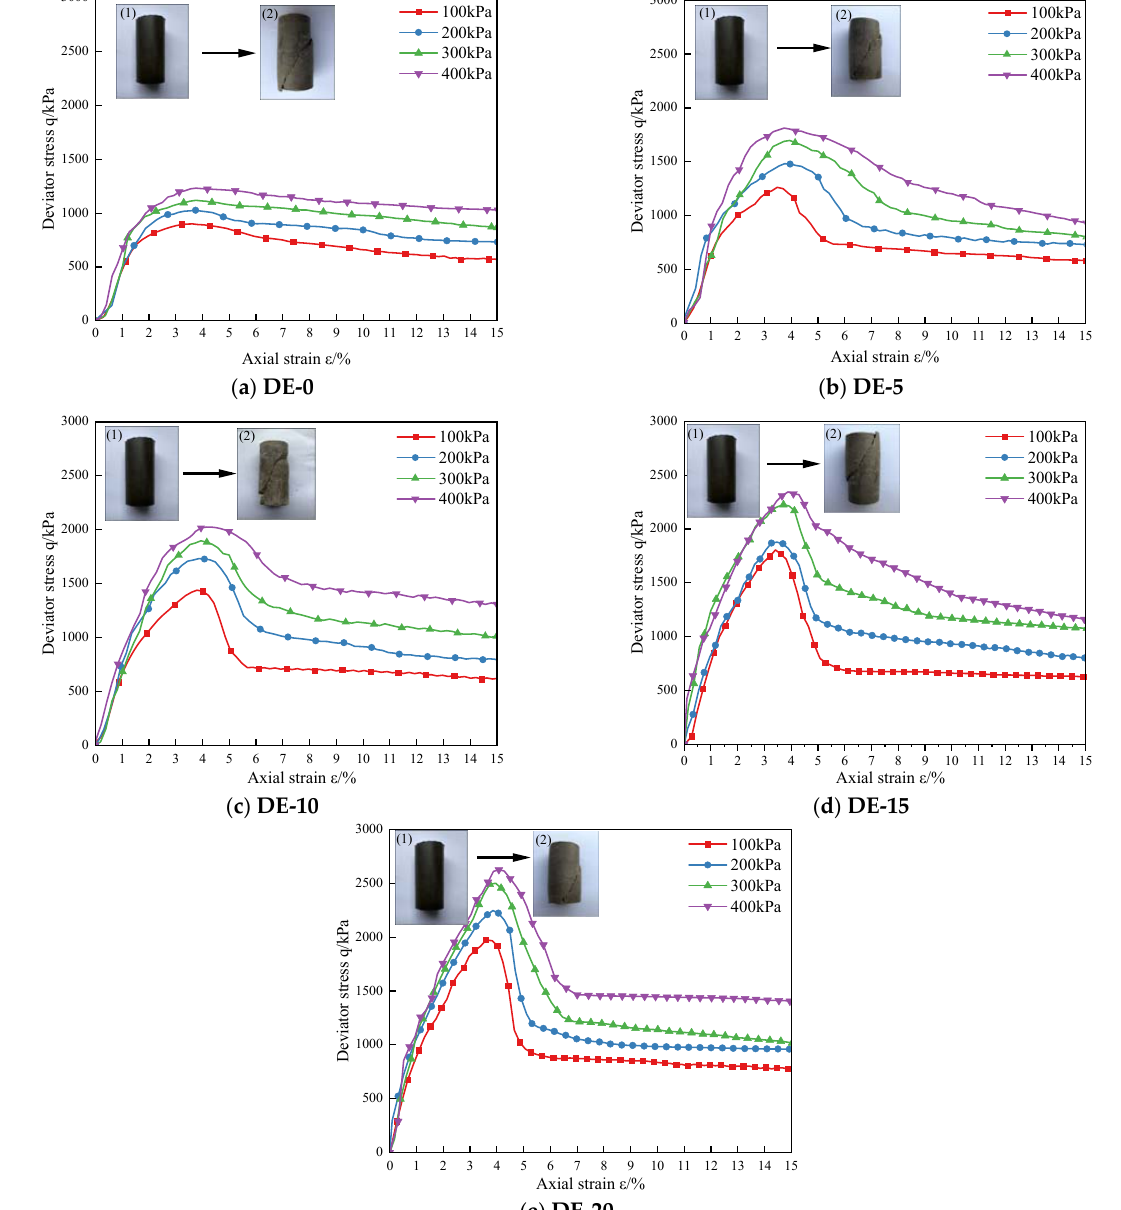
Figure 6. Deviatoric stress–strain relationship curves of specimens with different diatomite contents. (1) and (2) are the initial and failure images of specimens, respectively.